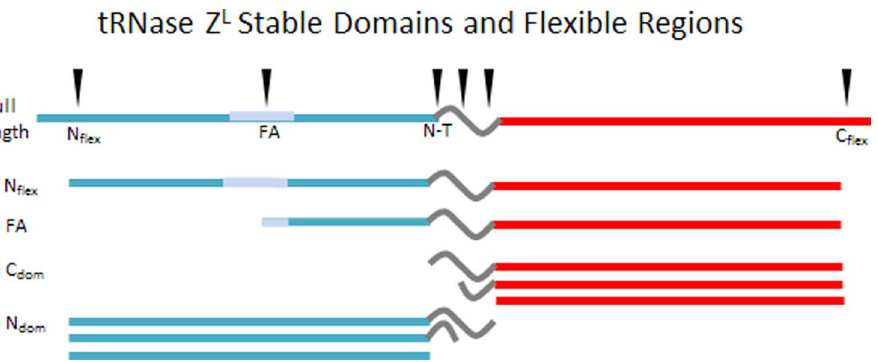
Figure 11. Tethered domains and flexible regions in tRNase Z L . Polypeptides characterized in the limited proteolysis experiments define the stable domains and flexible regions in tRNase Z L illustrated in the diagram. Most of the proteolytic cleavages fall into four flexible regions, designated N flex , FA, Tether and C end , producing polypeptides designated N flex , FA, N dom and C dom . Two main flexible regions in tether produce N dom and C dom polypeptides varying in length as